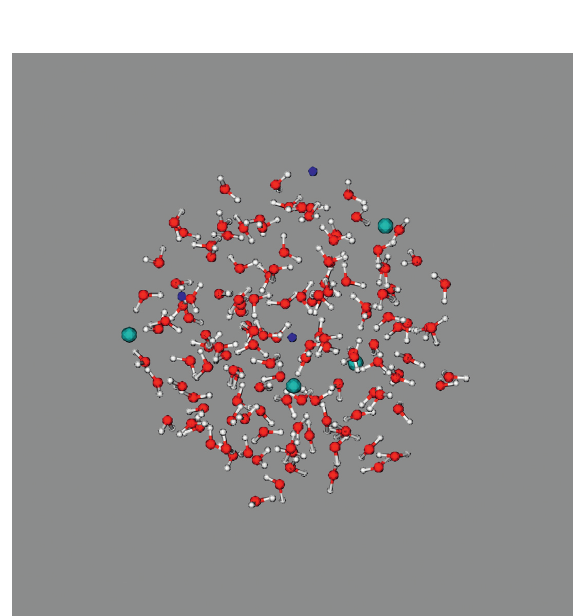
Figure 7: Logarithm of residence time correlation functions for the hydrated SPC/E water molecules at 25 ° C in the first hydration shell of Na+ and Cl- and that for Na+or Cl-in the coordination shell around Cl- or Na+ with R 1 � 9.95 ˚A obtained from our MD simulations with κ � 0.10 ˚ A −